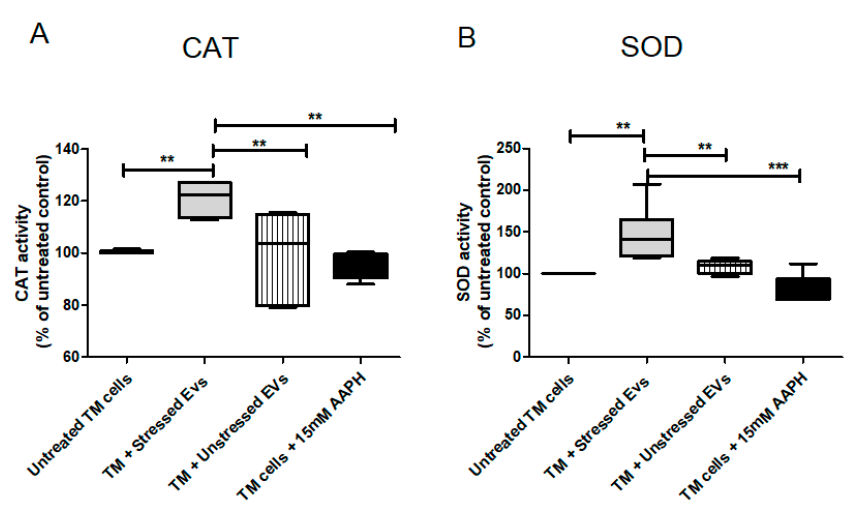
Figure 9. Effects of pretreatments with NPCE EVs on SOD and CAT enzyme activities in TM cells. Proteins from TM cells were extracted 24 h post-NPCE exosomes treatment and used as source of SOD or CAT. Quantification of the antioxidant activity of ( A ) CAT and ( B ) SOD in TM cells. The results are mean±SEM of 4 different experiments. Significance tested by one-way ANOVA and Tukey’s post hoc analysis. Levels of significance are marked with symbols ** p < 0.01, *** p < 0.001.